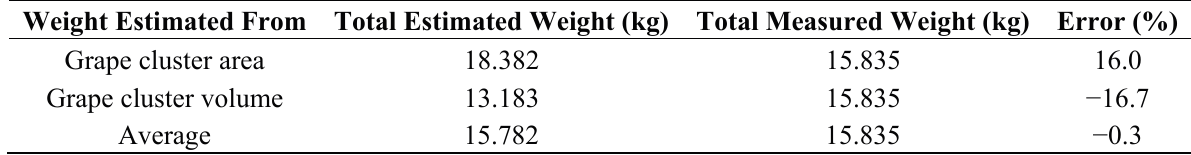
Table 2. Total yield estimate for the case of 25 clusters of